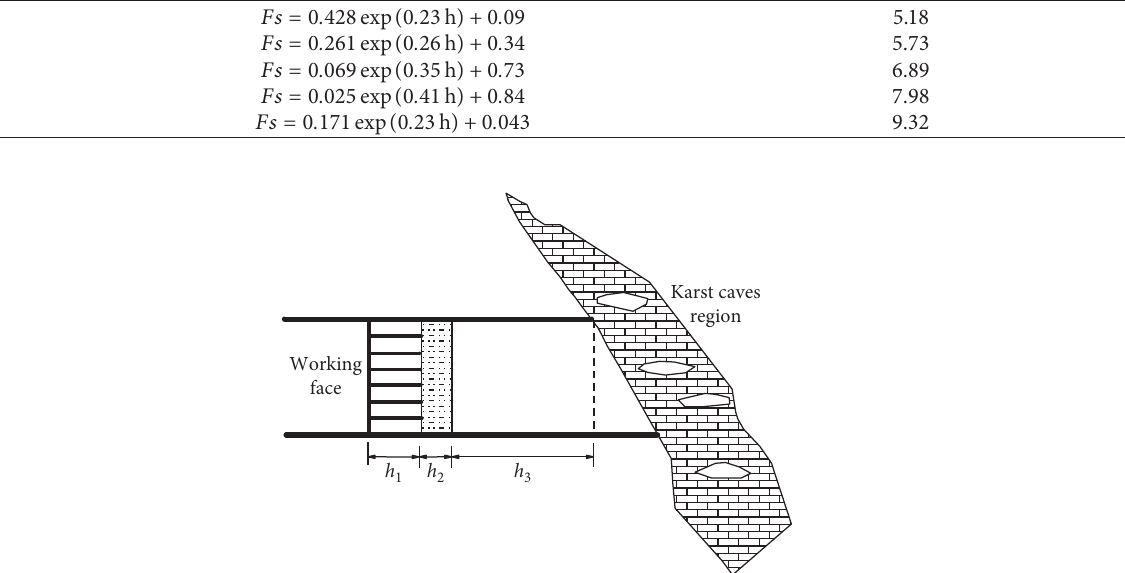
Table 2: The relation between safety factor F Karst cave water pressure (MPa)